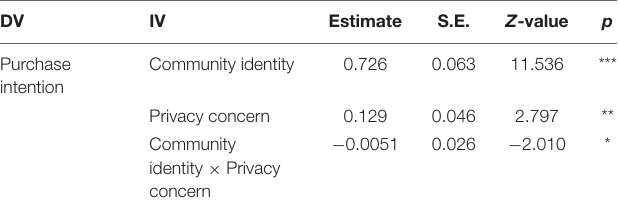
TABLE 5 | Regression coefficient.